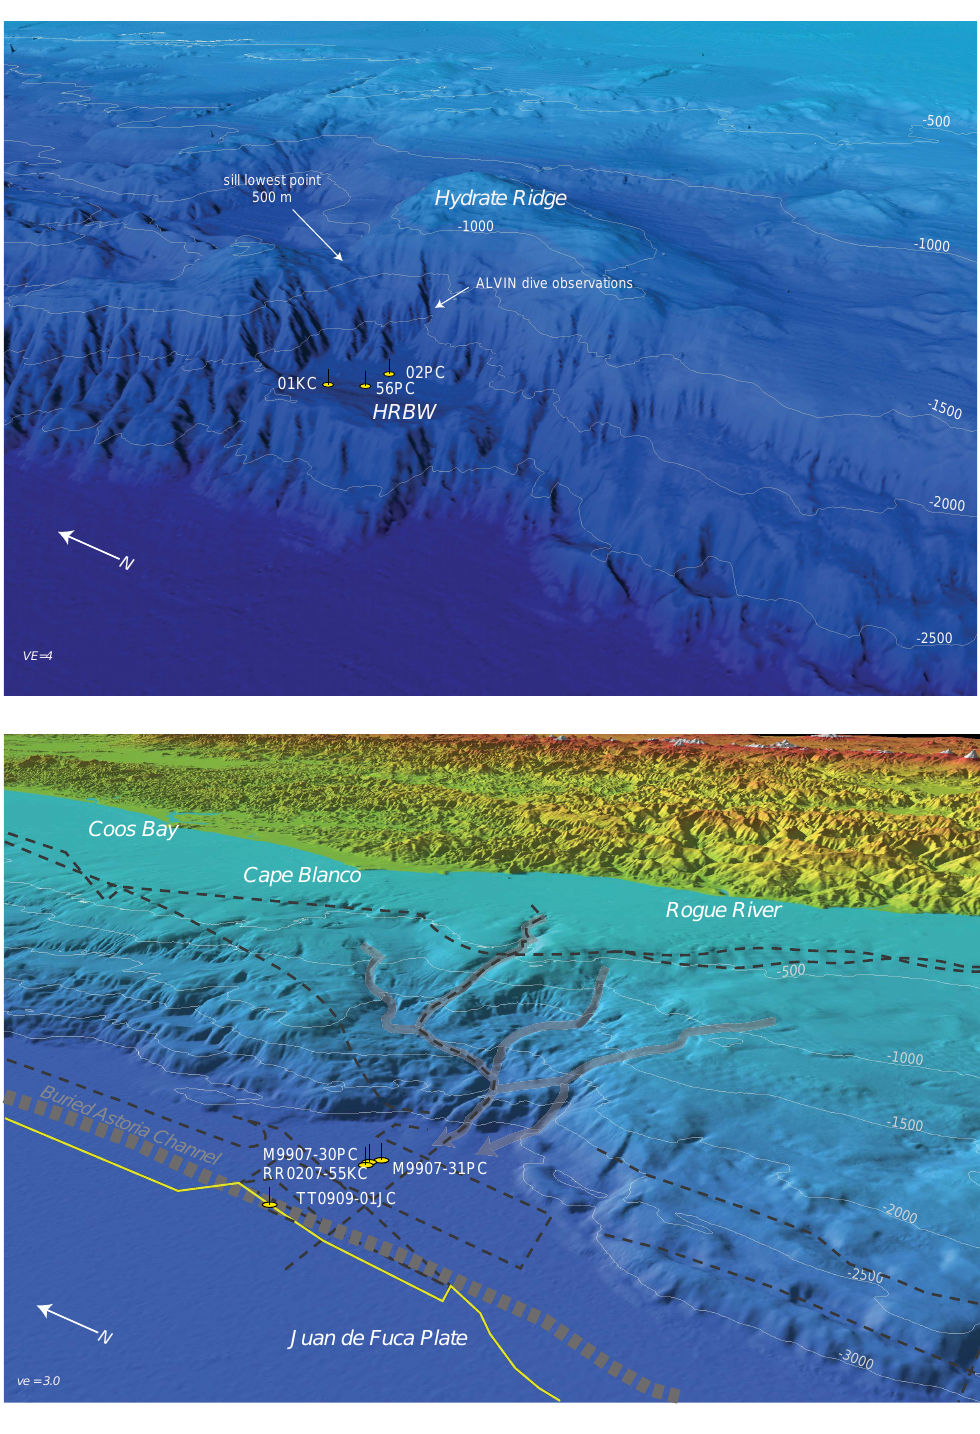
Fig. 2. (A) Shaded perspective view of Hydrate Ridge west basin (HRWB) on the central Oregon margin. The basin is protected on all sides from terrestrial sediment input by structural sills with heights of ∼ 500m to the north, 1800m to the east, and 1200m in the south. (B) Perspective shaded view of bathymetry of the Rogue Canyon system and apron, southern Oregon margin. Multiple canyon tributary pathways are shaded grey. No topographic expression of a channel leading from the Rogue Canyon is apparent at the resolution of the multi- beam bathymetry. Similarly, the buried Astoria Channel (foreground) has no bathymetric expression at this latitude. The 3.5kHz reflection tracklines shown. Lines shown in Figs. 9 and 10 are indicated in yellow. Inset shows approximate a and b locations with yellow